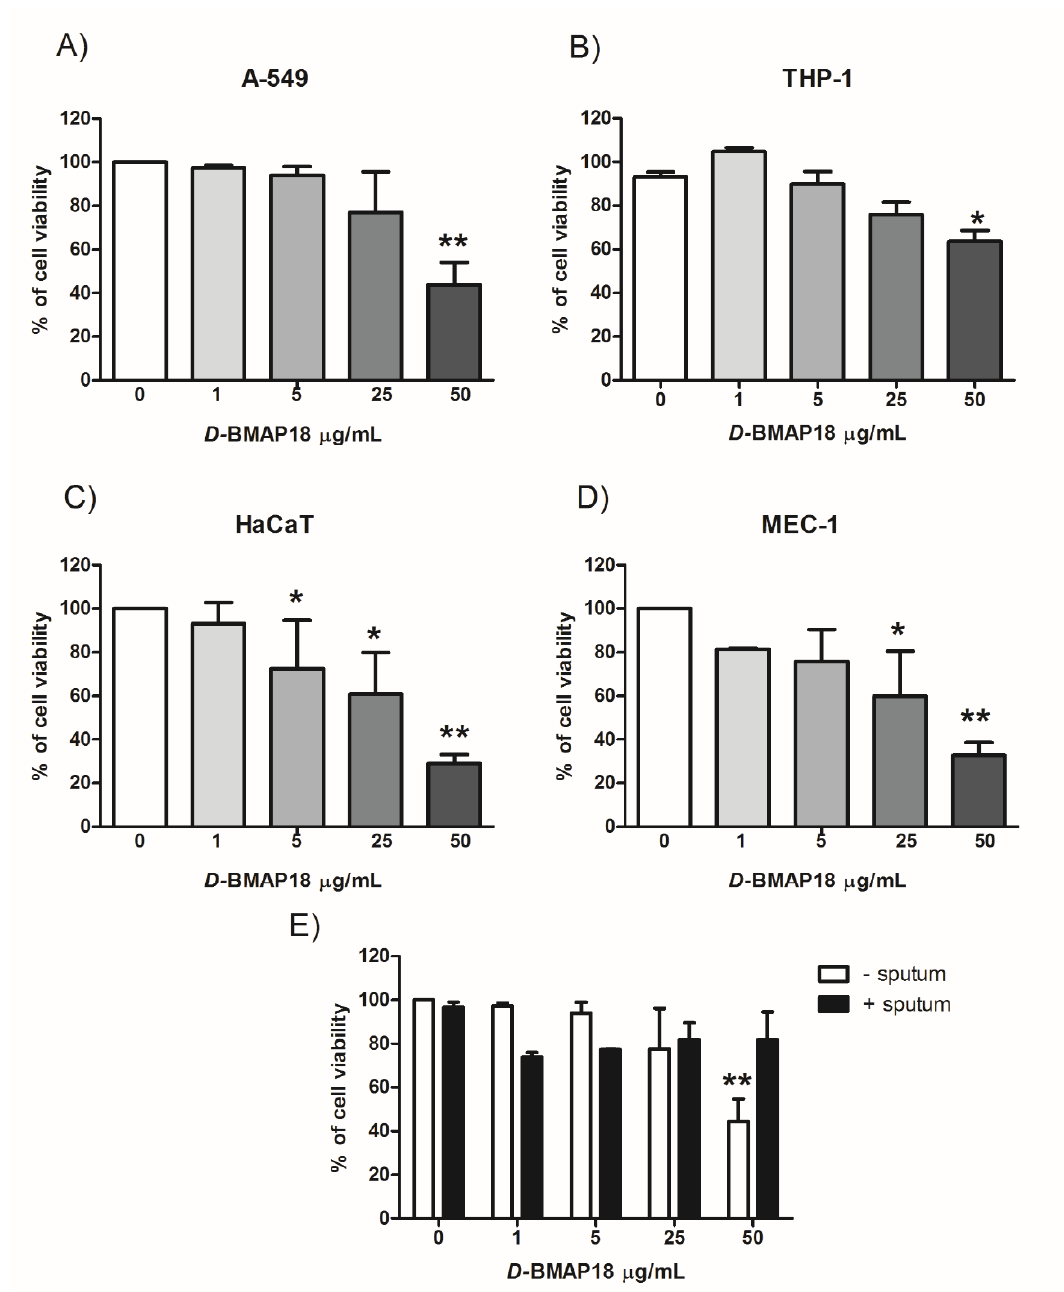
Figure 4. E ff ects of D -BMAP18 on the viability of human cell lines. MTT assay against lung carcinoma A-549 cell line ( A ), monocytic THP-1 cells ( B ), keratinocyte HaCaT cells ( C ), and lymphocytic leukemia MEC-1 cells ( D ) are shown. Data are expressed as percentages of viable cells compared to the untreated control after 24 h of treatment with di ff erent concentrations of D -BMAP18. ( E ): D -BMAP18 cytotoxicity of pulmonary A-549 cell line in the presence and in the absence of 25% CF sputum. The results are the average of three independent experiments in internal triplicate ( n = 9). * p < 0.05, ** p < 0.01, Student t test, treated vs untreated